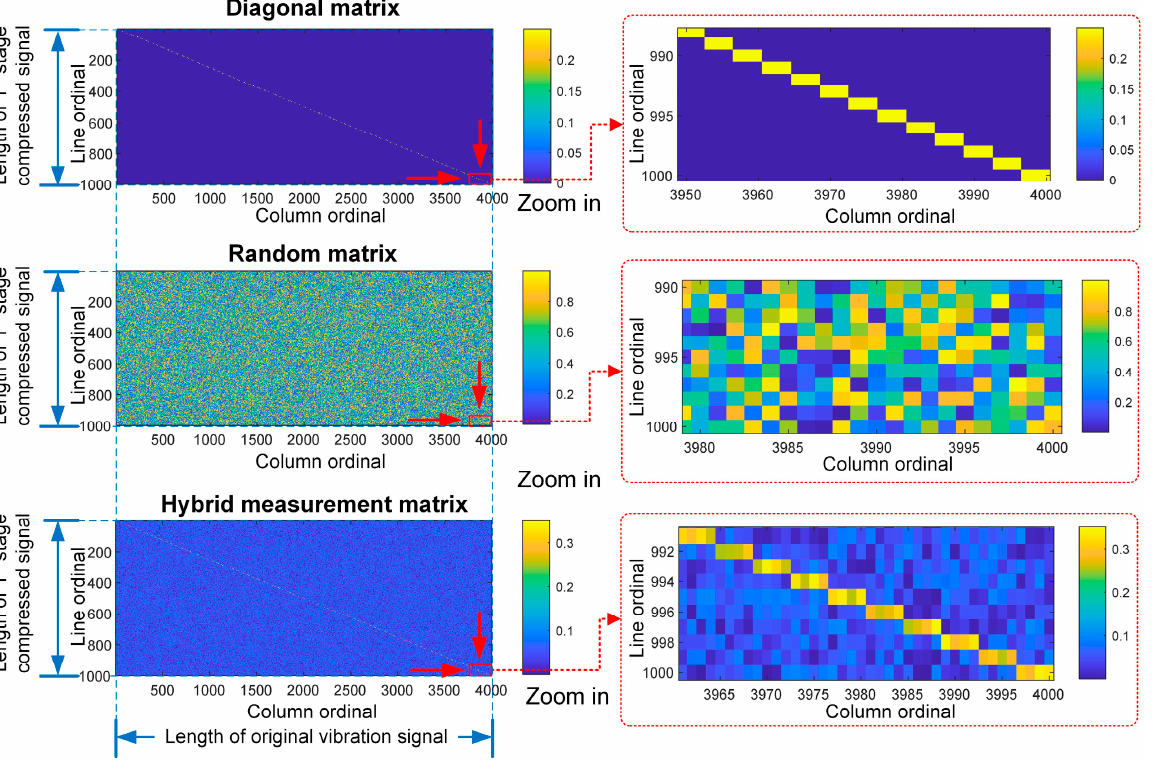
Figure 21. RPD: hybrid measurement matrix. The vibration signals acquired from the vertical, horizontal, axial vibration sensors were combined as a column vector whose length was 3 M 1 = 3 × 500 = 1500, and the column vector was compressed and fused using a pre-designed joint measurement matrix Φ = 0.1). The consolidated frequency spectrum is shown in Figure 24a, the mea- F ( β surement matrix Φ F is shown in Figure 24b, and the compressed spectrum is shown in Figure 24c. In Figure 24b, the size of Φ F is M 2 × 3 M 1 = 300 × 1500; thus, the compression rate was 300 ÷ 1500 = 0.2. Based on Equation (18), the spectra were compressed and fused synchronously; Figure 24c shows the compressed spectrum ν , of size M 2 = 300. The compressed spectra were used to construct the dictionary matrix, and the number of rows of the dictionary matrix was also M 2 =